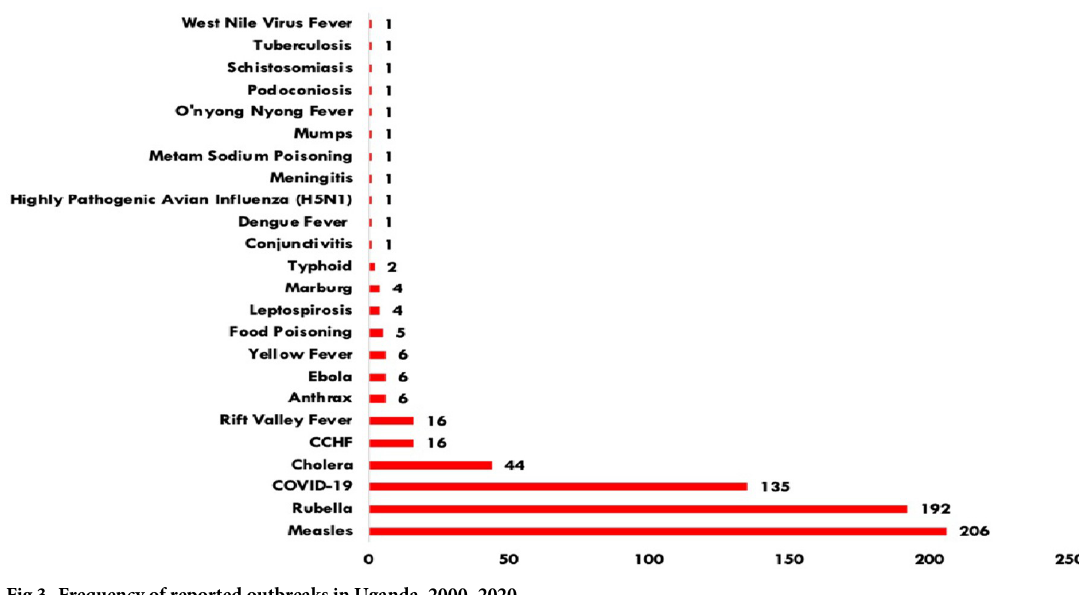
Fig 2. The number of outbreaks reported in Uganda, 2000–2020.